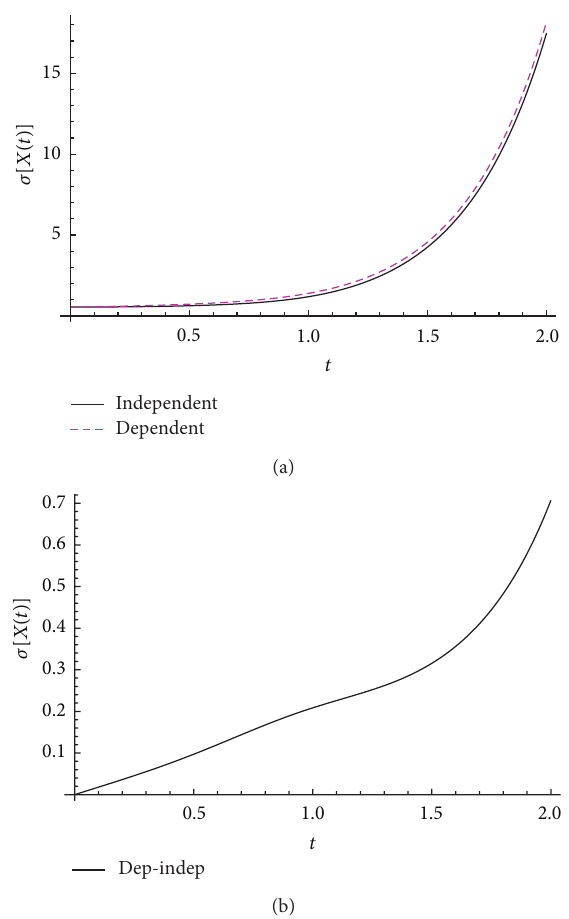
Figure 6: (a) Comparison of the approximations for the standard deviation 𝜎[𝑋(𝑡)] on the time-interval 𝑡 ∈ [0,2] in Example 4 by using Fr¨obenius and Polynomial Chaos. We assume that 𝜂 = ,𝑌 ) ⊤ follows a multivariate Gaussian distribution: 𝜂 ∼ (𝐴, 𝑌 0 1 ; Σ ) where 𝜇 = (−2,3, 6) ⊤ and Σ 1 Σ 2 𝑁( 𝜇 𝜂 𝜂 𝜂 𝜂 and 𝜂 are given by (35) corresponding to statistical independence and dependence, respectively. (b) Difference between the approximations showed in the figure on